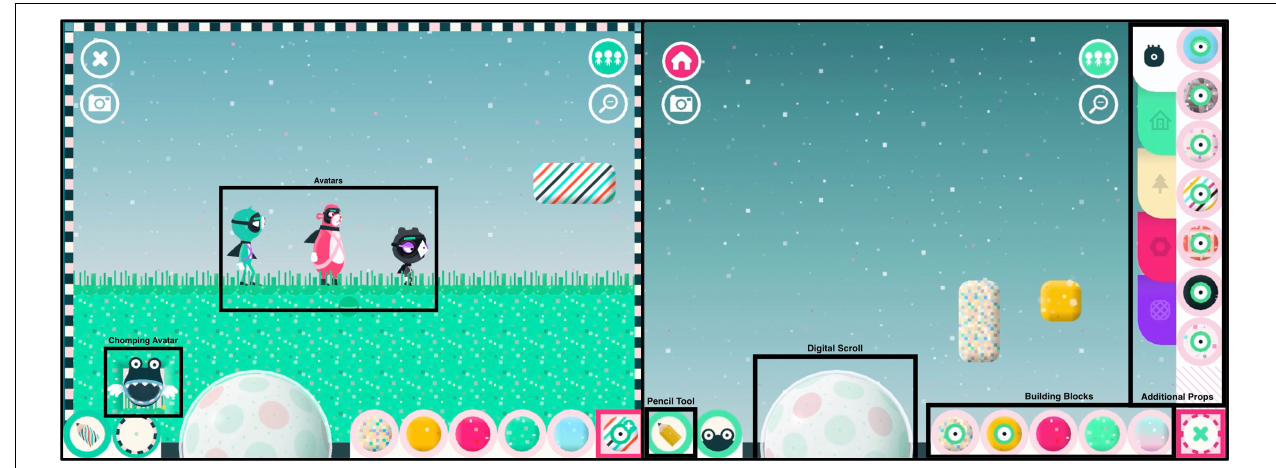
FIGURE 3 | The left side of the figure showcases the avatars with which children can play. The right side of the figure showcases the tools available for children to use to build structures and explore the environment.